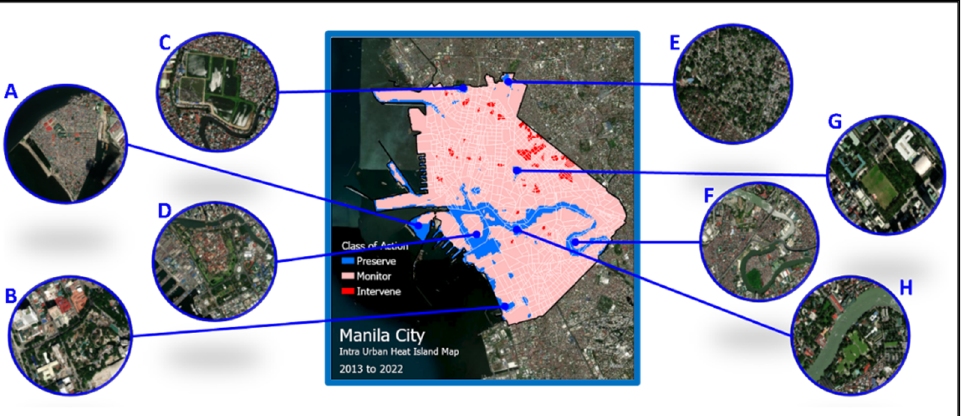
Figure 15. Some areas with the “Preserve” Class of Action. (A-H) are the areas highlighted to show their morphologies.